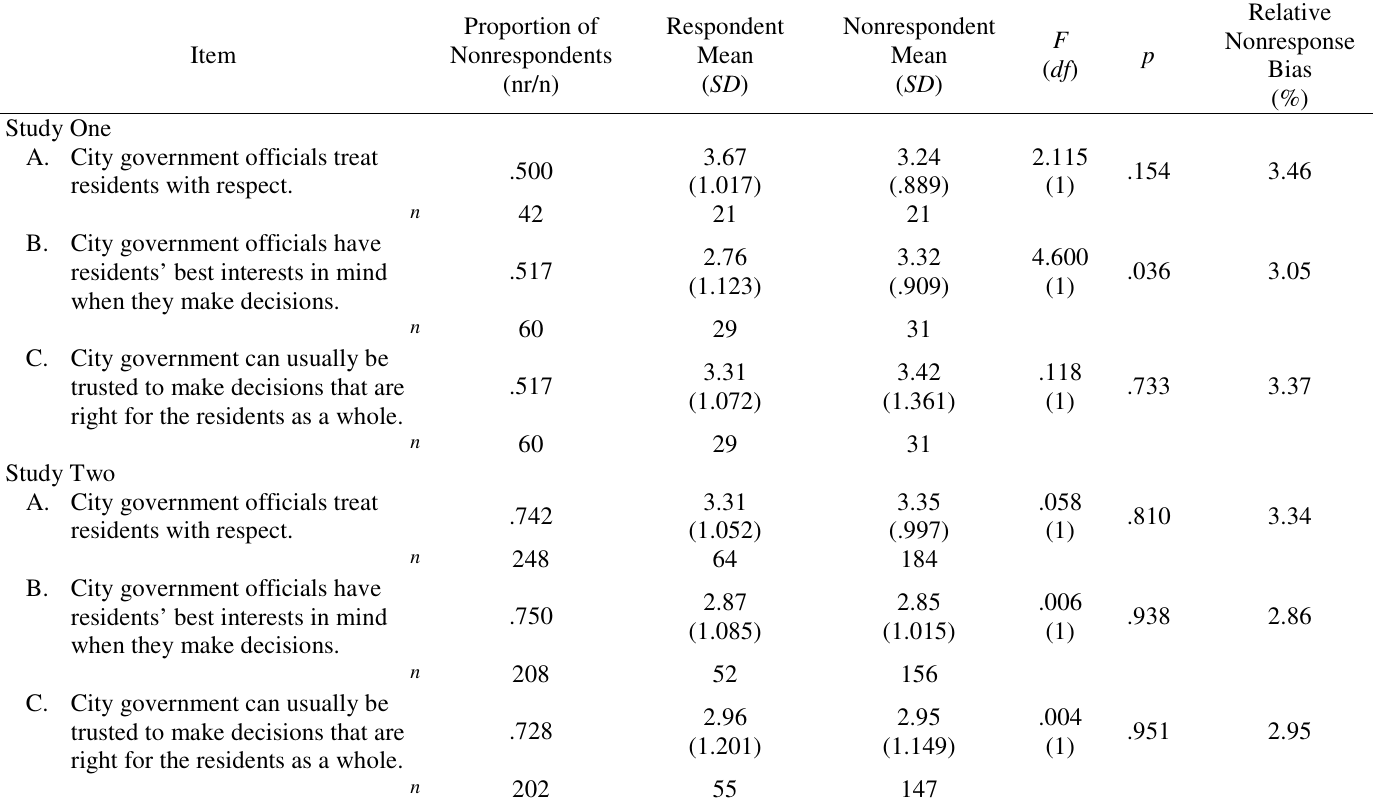
Table 5. Attendance nonresponse error